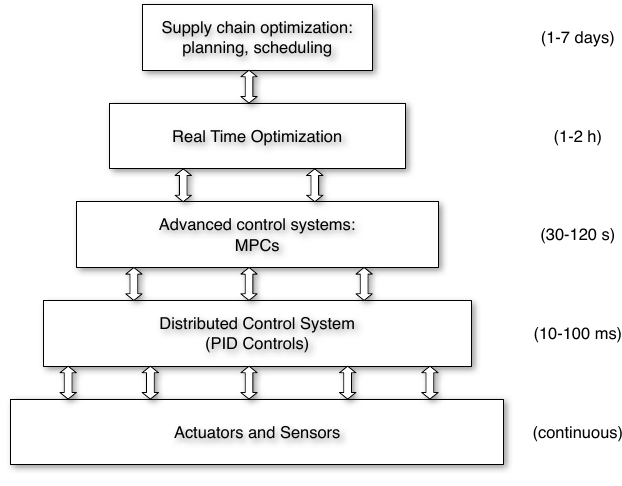
Figure 1. Typical hierarchical optimization and control structure in process